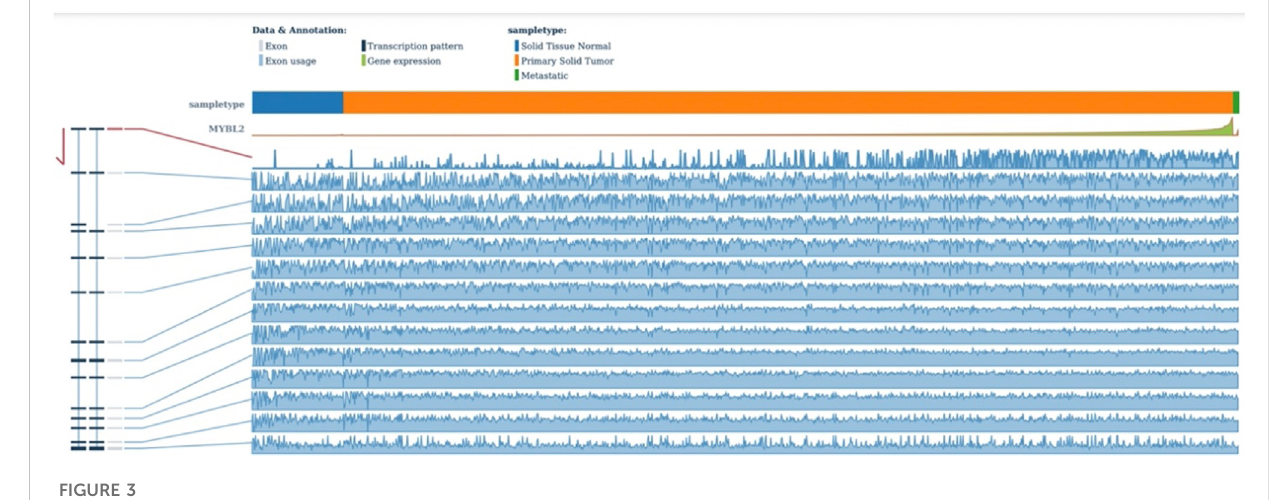
FIGURE 3 TSVdb outputs the expression of each exon of MYBL2 .